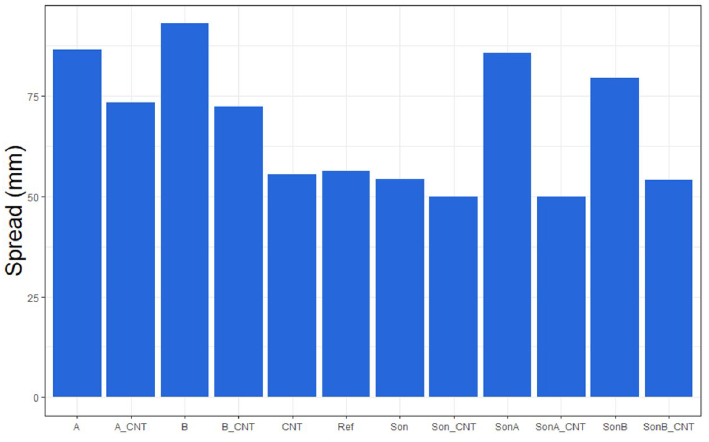
Figure 5. Spread of cement Portland pastes.